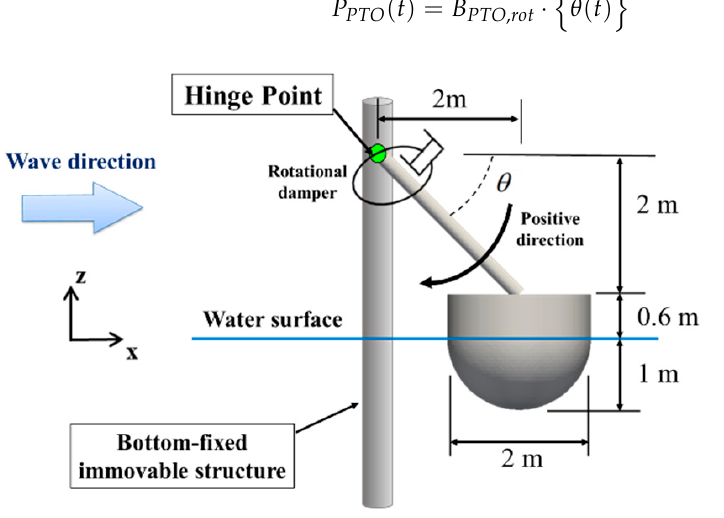
Figure 9. Model description of an HPA-type WEC model with a single hemispherical float constrained